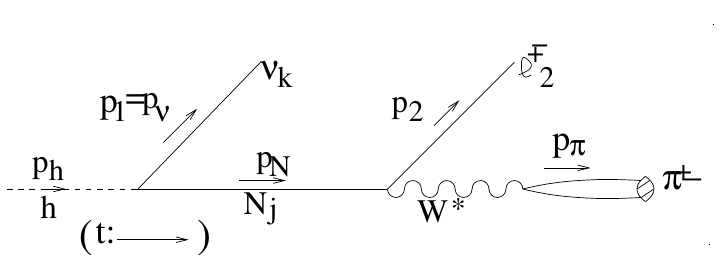
Figure 1 . The decay h ( p h ) → ν k ( p 1 ) N j ( p N ) → ν k ( p 1 ) ‘ ∓ shell (i.e., M N < M h j